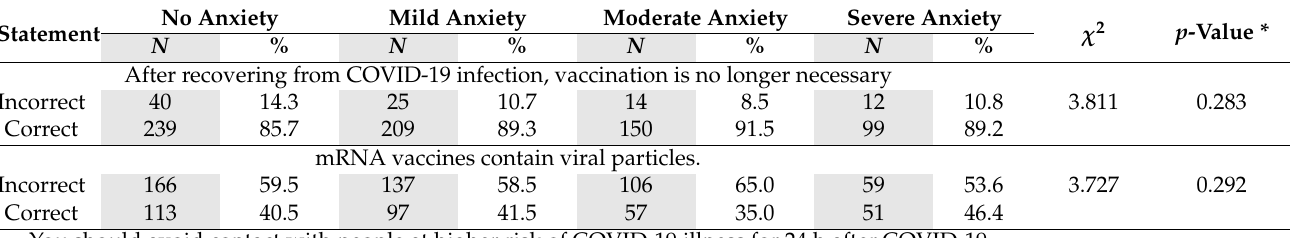
Table 5. Knowledge about vaccination and anxiety